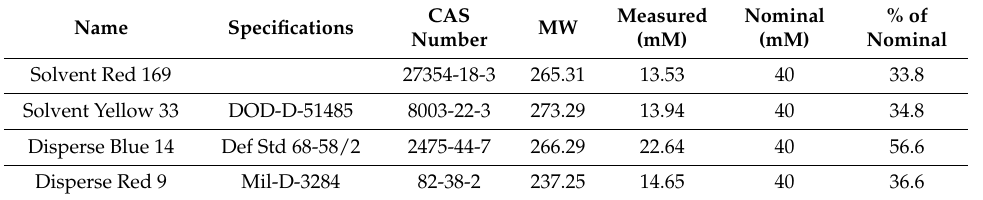
Table 1. Analytical chemistry analysis showing nominal versus measured